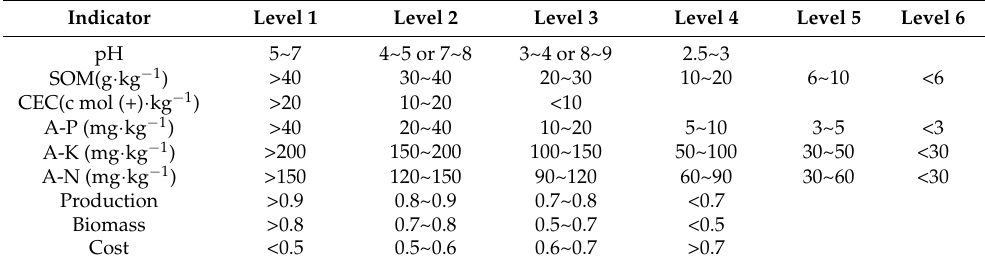
Table 5. Reference Table for Grading Evaluation